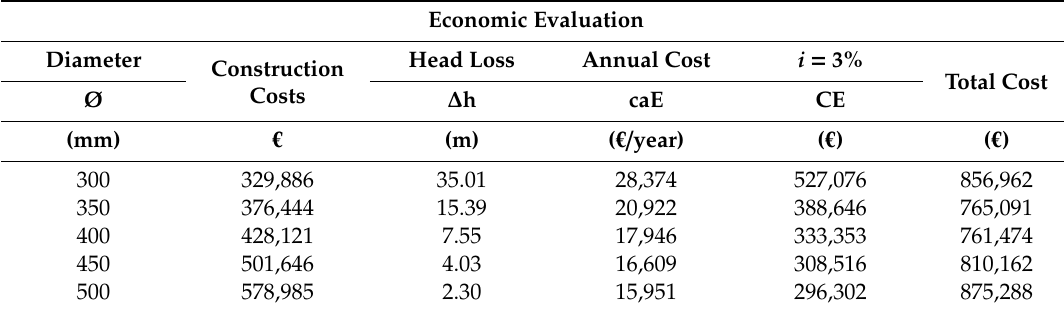
Table 4. Economic evaluation for the case study using the project prices for the pipes, once a diameter of 400 mm has been selected, to prove the least cost